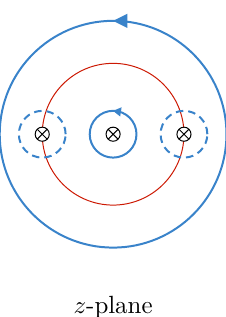
Figure 2 . The contour integral for computing the matrix correlator f ( x ) in z -plane (the big circle) gets contribution only from the pole of f ( x ( z )) at z = 0 . The residue at poles of resolvent (dashed circles)